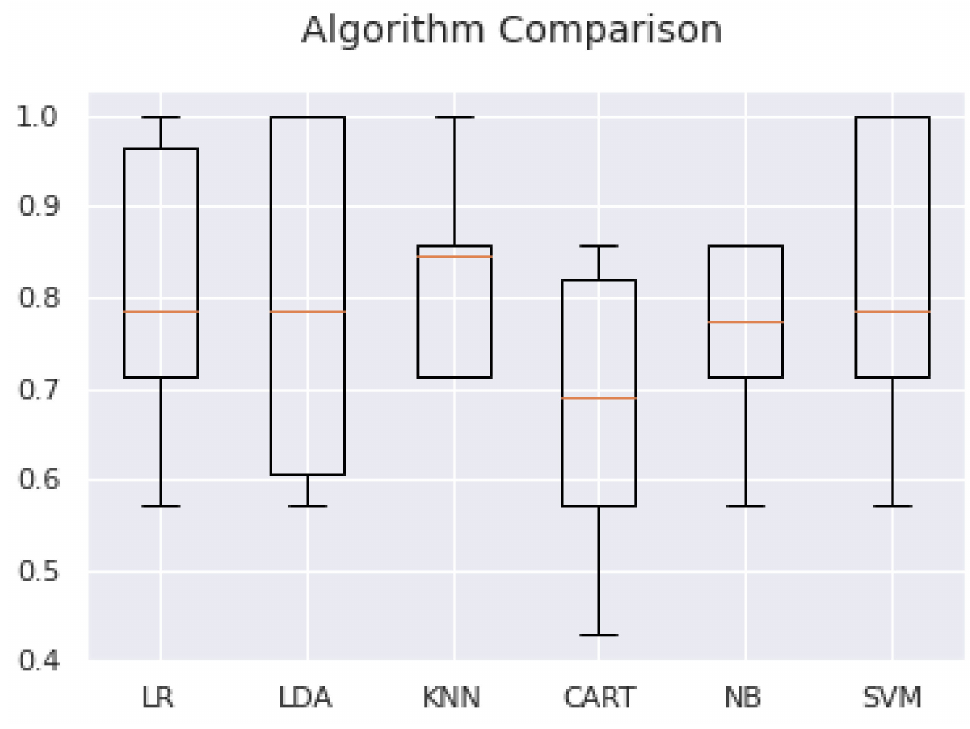
Figure 2. Comparison of machine learning algorithms for the feature reduction analysis. The GBM algorithm improved from mean accuracy: 0.695 (0.142) to 0.811905 using {‘learning_rate’: 0.0001, ‘max_depth’: 3,’n_estimators’: 10, ‘subsample’: 0.5} and the